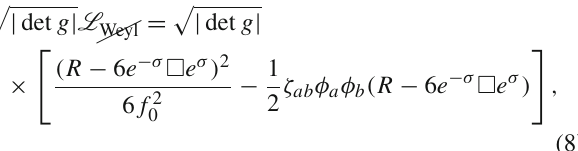
Table 1 Transformations of coordinates and fields under a Weyl transformation